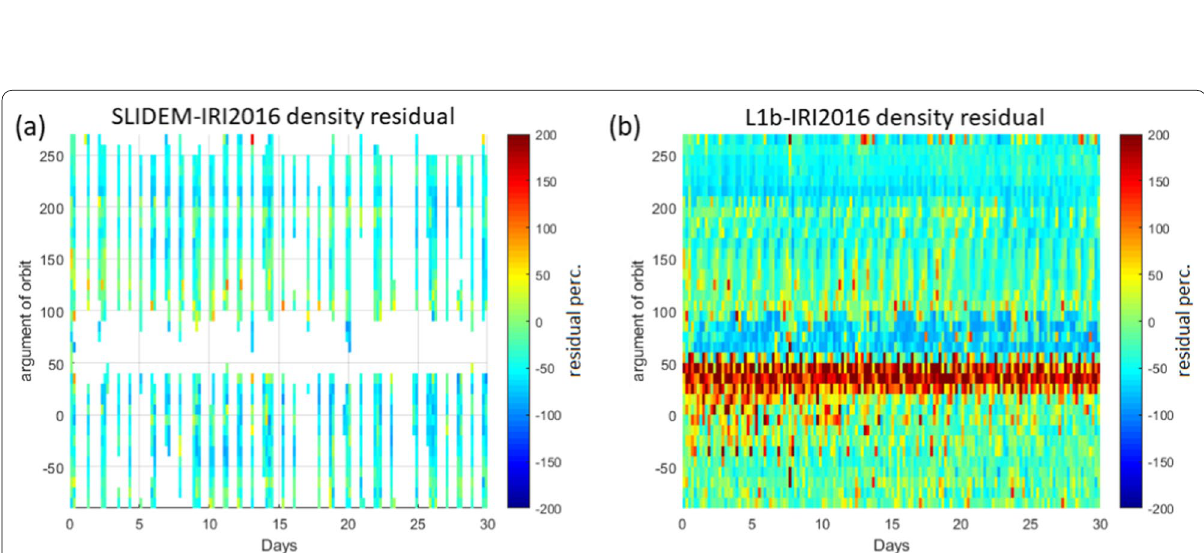
Fig. 3 Statistical analysis of the residual of density estimates between SLIDEM (IDM) and IRI-2016, as well as Level1b and IRI, for the time period 1–30 January 2018. Gaps in (a) denote periods of missing SLIDEM data coverage. Residuals are in units of percentage of the total